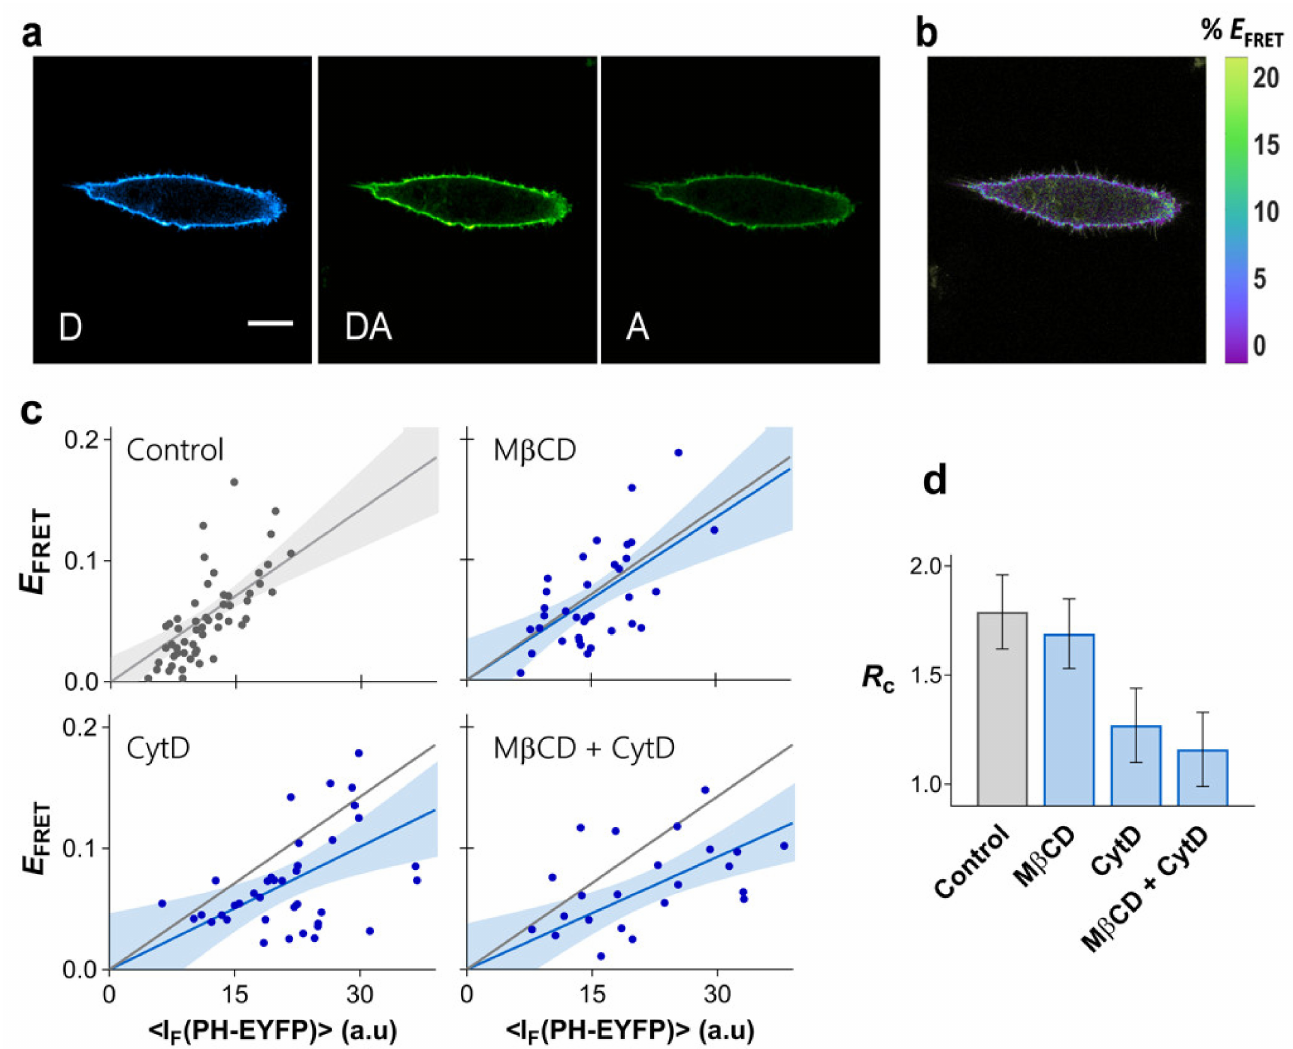
Figure 4. Clustering of PI(4,5)P 2 in HeLa. FRET microscopy of HeLa cells co-transfected with PH PLC δ -ECFP and PH PLC δ - EYFP. ( a ) Example of confocal data acquired according to the three-filter cube method: D—donor channel, DA—FRET channel, A—acceptor channel. Scale bar = 5 µ m. ( b ) FRET efficiency image. ( c ) Dependence of E FRET on PH PLC δ -EYFP fluorescence intensity. Each data point corresponds to the FRET signal at a segment of the plasma membrane of an individual cell (at equatorial optical sections). The lines represent the least-squares fit of Equation (2) to the data sets and the corresponding 95% confidence intervals are shown as the shaded areas. FRET was measured on unperturbed cells (control), and on cells exposed to M β CD for cholesterol extraction, or to CytD for disruption of the cytoskeleton. A combined M β CD + CytD treatment was also carried out. The grey line is the fit to the FRET data in the absence of cytoskeleton disruption and is shown for comparison. ( d ) R C values obtained for PH PLC δ -ECFP/PH PLC δ -EYFP ( ±